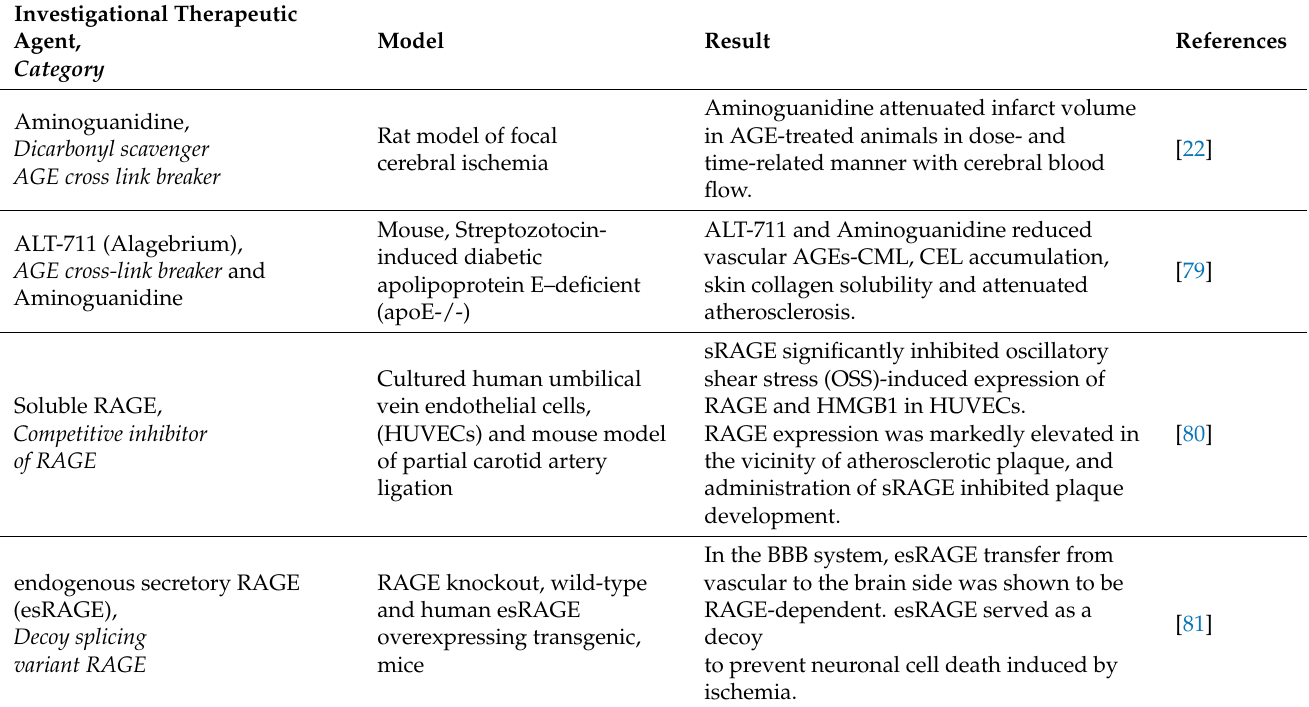
Table 2. Experimental findings on investigational/candidate therapeutic agents against AGE–RAGE axis in diabetic cardio-cerebrovascular